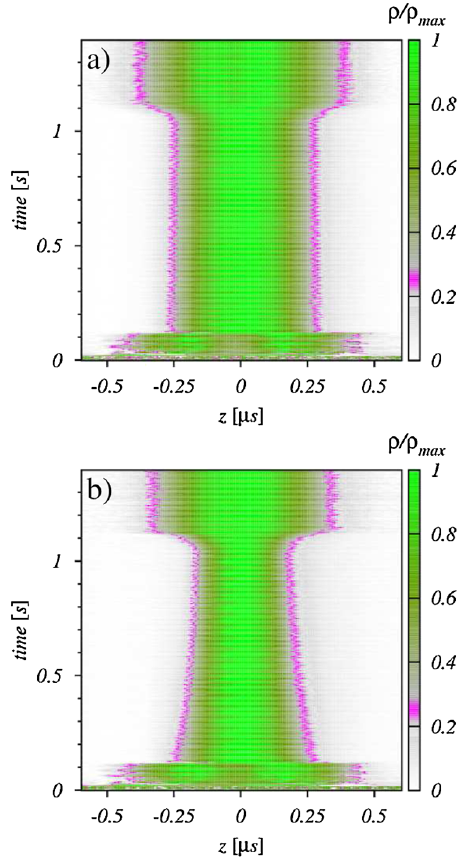
FIG. 17. High intensity bunched beam: Longitudinal beam evolution at Q x ¼ 4 : 3425 and Q x ¼ 4 : 3365 . For the case Q x ¼ 4 : 3365 the shortening of the beam tails is